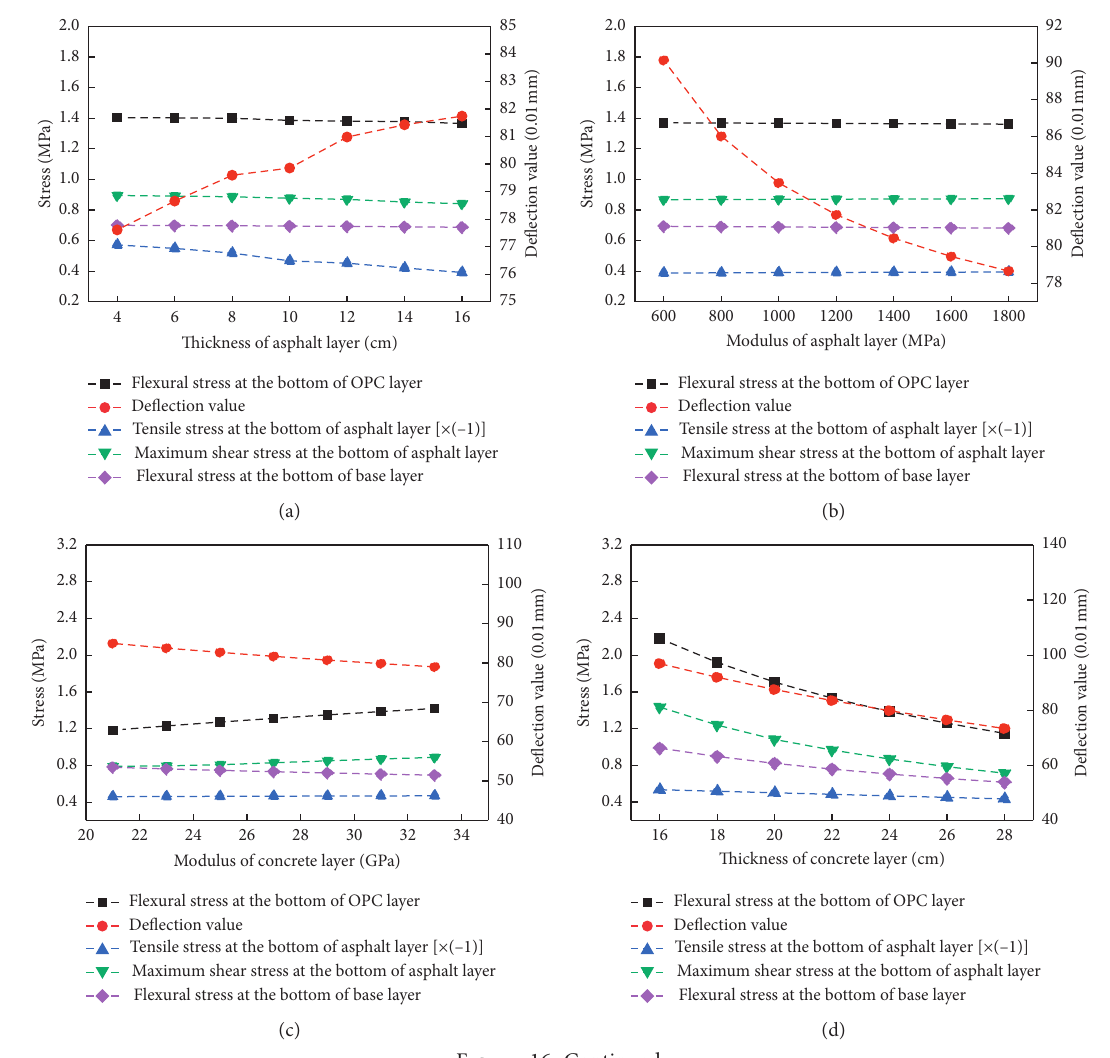
Flexural stress at the bottom of OPC layer Deflection value Tensile stress at the bottom of asphalt layer [×(–1)] Maximum shear stress at the bottom of asphalt layer Flexural stress at the bottom of base layer